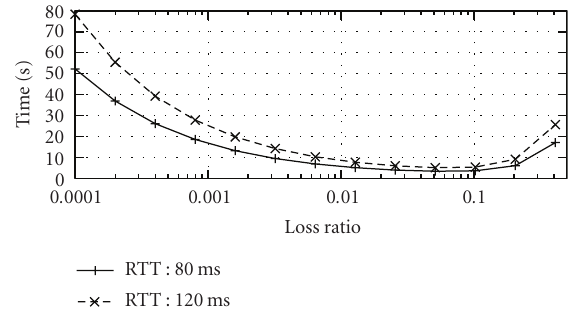
Figure 4: The sampling time length of